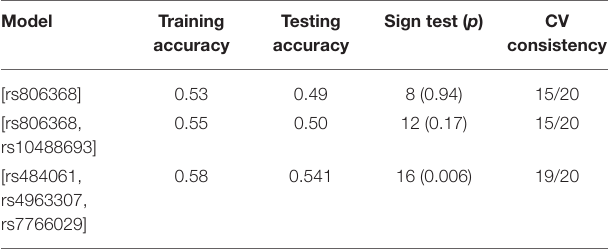
TABLE 4 | Table of results for the best combinations defined by GMDR for 69 SNPs for AUDIT.